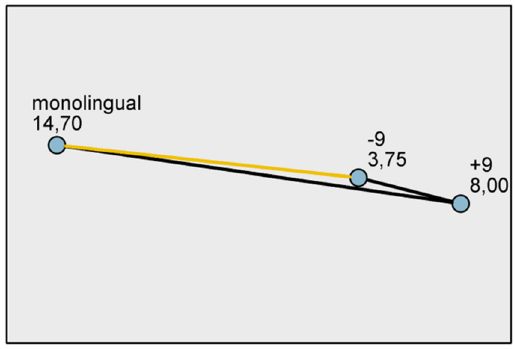
Figure 1: Pairwise post hoc test result for age groups.